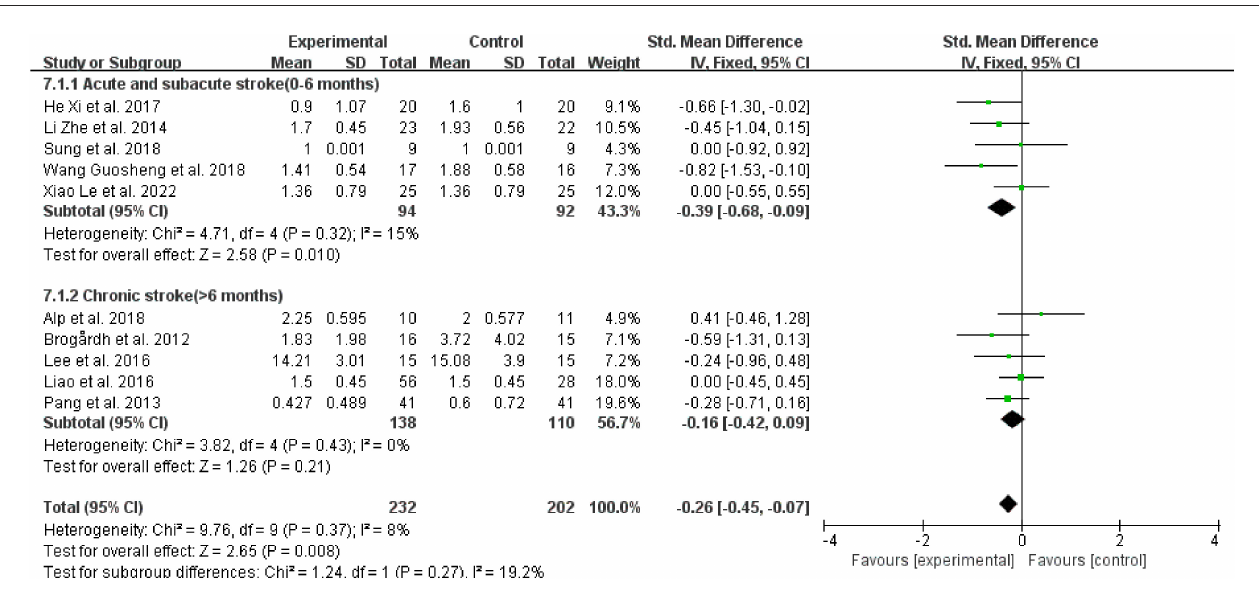
to one study (41), five modest side effects (fatigue, redness of the